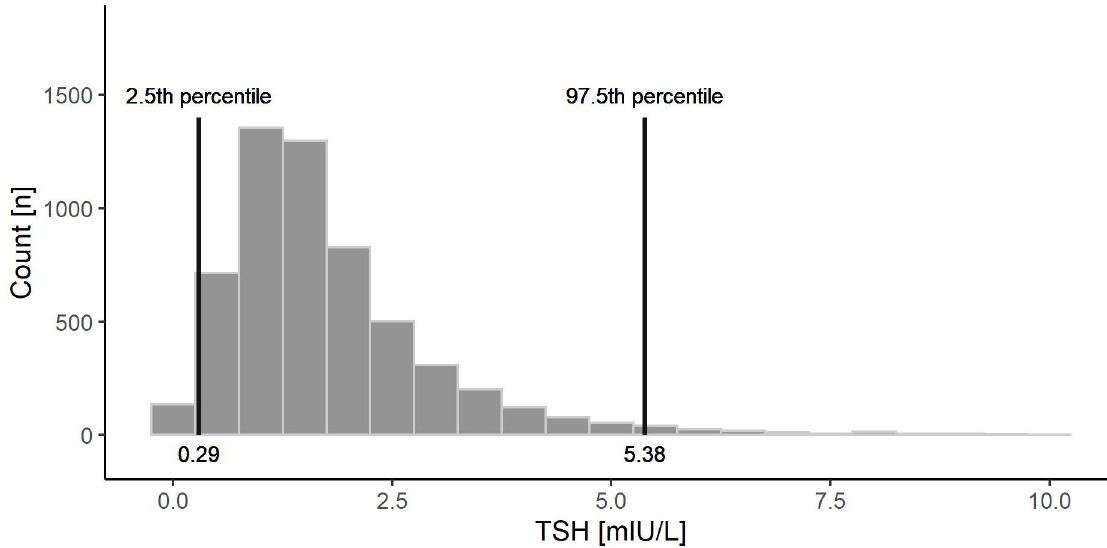
Fig 2. Distribution of serum TSH levels in the study cohort with marked values for 2.5 and 97.5 percentiles.